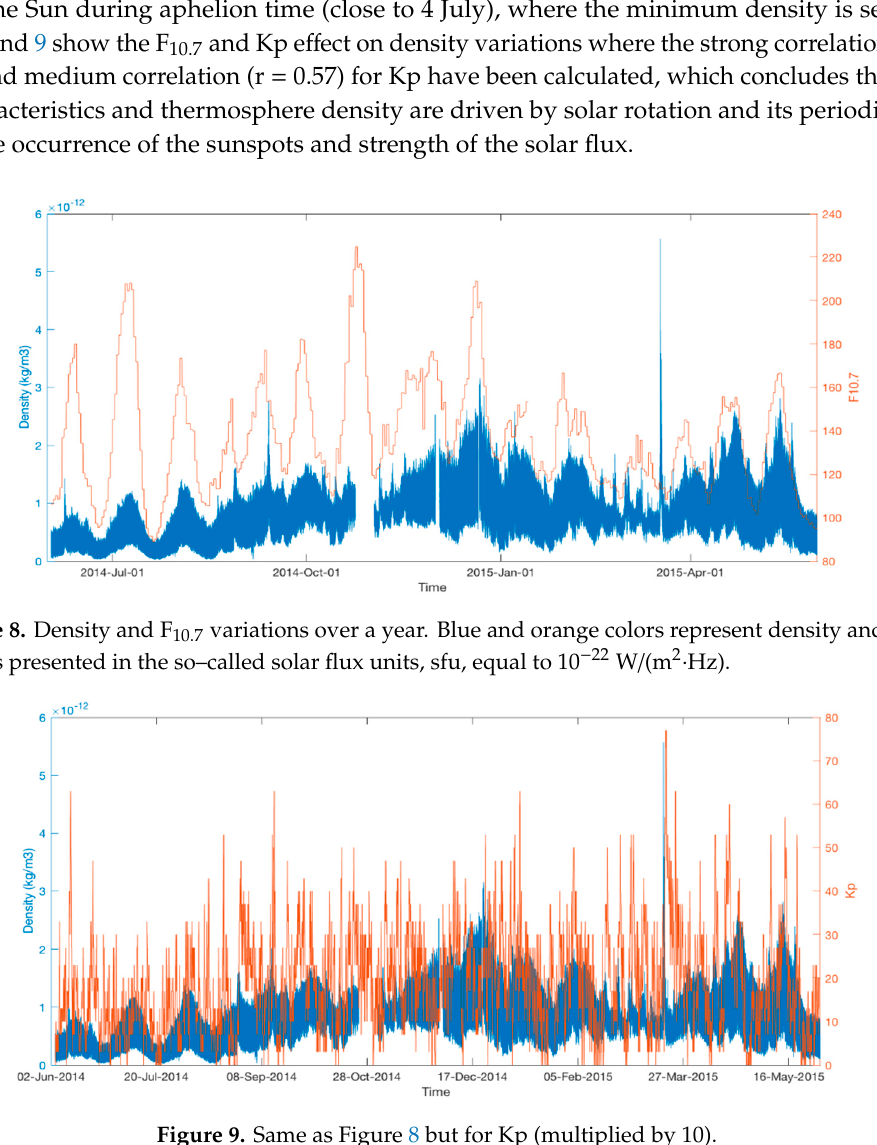
Figure 9. Same as Figure 8 but for Kp (multiplied by 10).